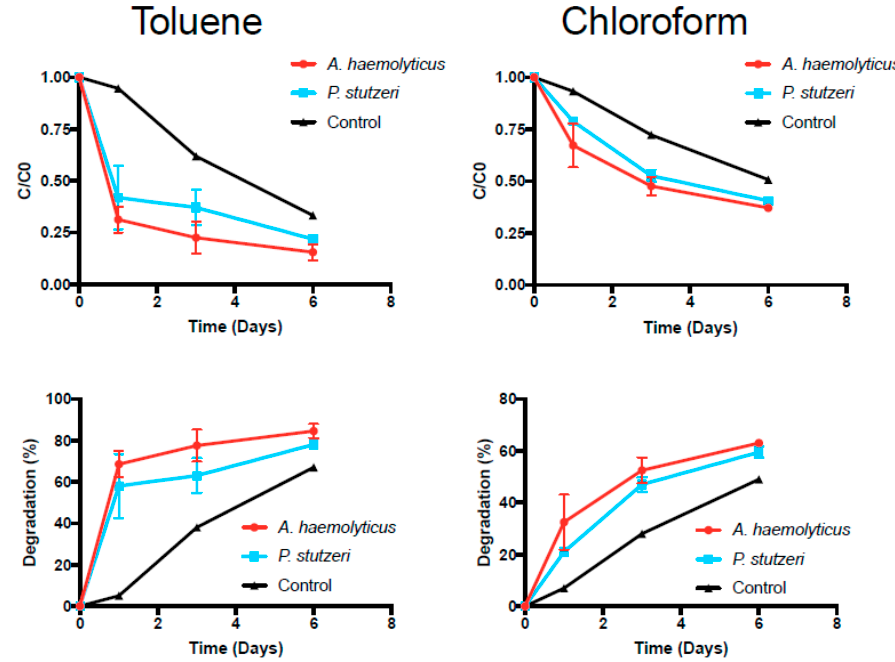
Figure 4. Degradation rates for toluene and chloroform. Data points represent the mean of two replicates, with the error bar representing the standard deviation.